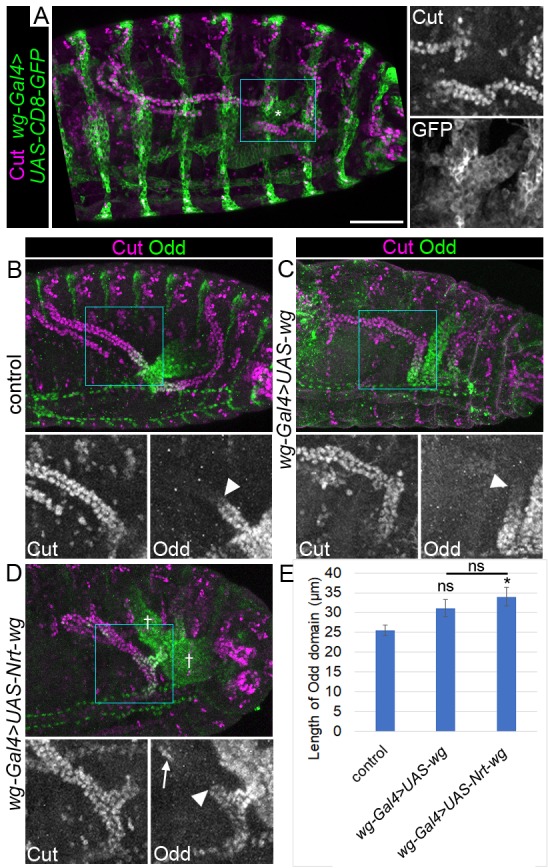
Incorrect patterning of proximal tubule is not result of dominant effect of Nrt-wg.Maximum intensity projections of approximately stage 16 Drosophila embryos, oriented anterior left. Scale bar = 50 μm. (A) An embryo in which the expression pattern of wg-Gal4 is determined using a UAS-CD8-GFP reporter (marking cell membranes) and staining with anti-GFP. Embryo is co-stained with anti-Cut to allow visualisation of tubules. Asterisk marks expression in presumptive midgut. Right panel shows enlargement of area marked with square. B-D show embryos stained with anti-Cut and anti-Odd, with lower panels showing enlargements of boxed areas, to highlight the region where the proximal tubule of the anterior tubule pair meets the gut. Arrowheads show the distal extent of the Odd expressing tubule domain. (B) Control embryo (wg-Gal4). (C) An embryo in which wg-Gal4 is used to drive expression of UAS-wg, in a wild-type wg background. (D) An embryo in which wg-Gal4 is used to drive expression of UAS-Nrt-wg in a wild-type wg background. In this context Odd is expressed in the gut beyond both sides of the junction with the Malpighian tubules (†) that is in both the midgut and hindgut. Arrow marks patch of cells in tubule expressing Odd. (E) Graph showing mean length of Odd expressing region along tubule in control embryos (UAS-wg), and embryos in with wg-Gal4 is driving the expression of UAS-wg or UAS-Nrt-wg. Error bars represent SEM. One-way ANOVA indicated a significant statistical difference between the three genotypes (p=0.04*). Control n = 14, wg-Gal4 >UAS wg n = 20, p=0.052 (Mann-Whitney, compared to control), wg-Gal4 >UAS Nrt-wg n = 25, p=0.012* (Mann-Whitney, compared to control) and p=0.35 (Mann-Whitney, compared to wg-Gal4 >UAS wg.